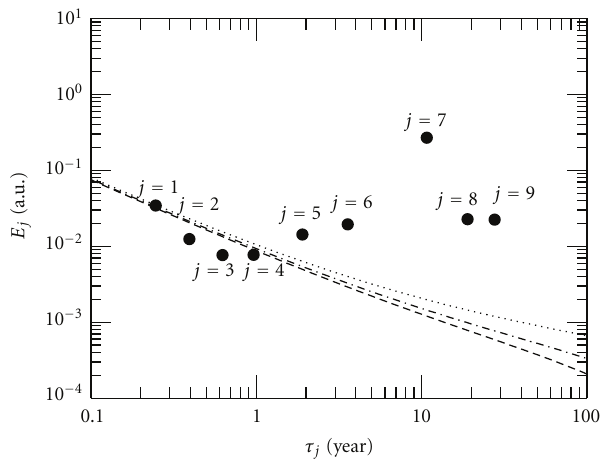
Figure 5: Average amplitude ( E j ) versus typical period ( τ j ) of the j IMFs ( j values from 1 to 9) identified in the SA data through the EMD. Dashed, dot-dashed, and dotted lines indicate the 90th, 95th, and 99th percentile, respectively.